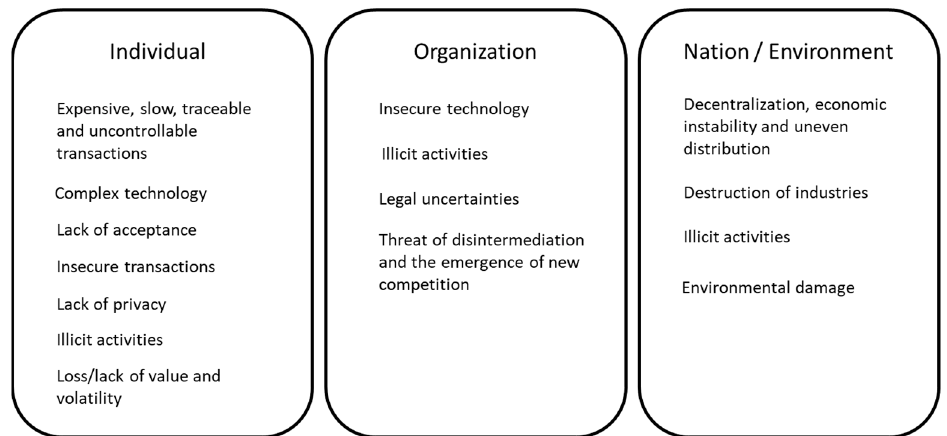
Figure 4. The “worst-case scenario” for Bitcoin.